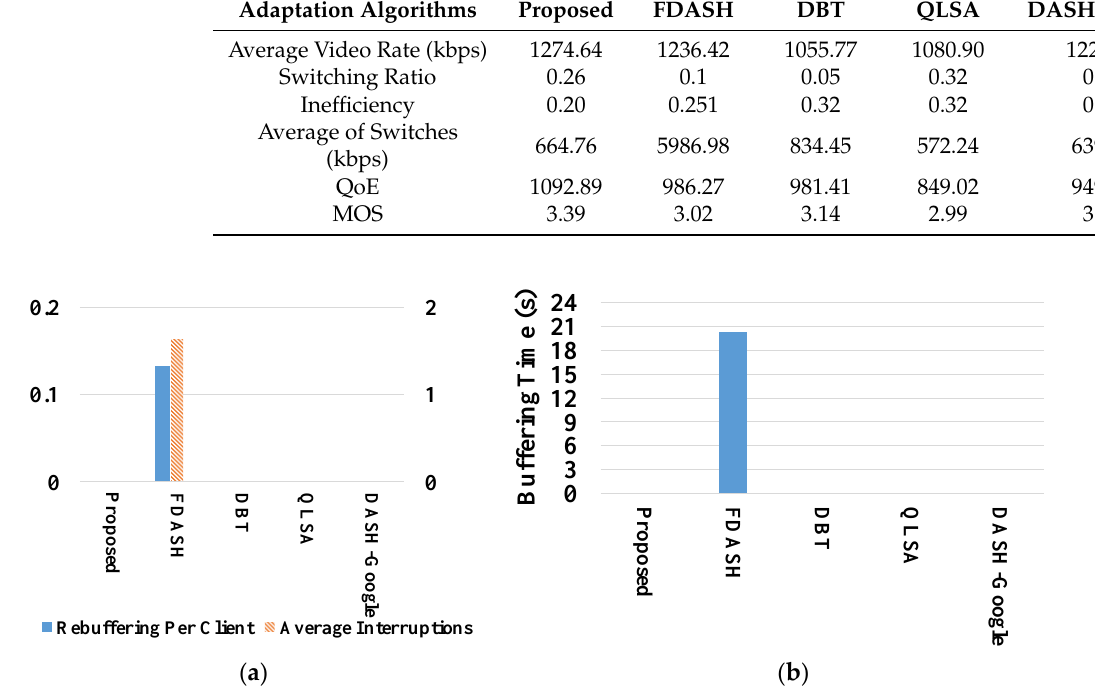
Figure 9. Comparison of ( a ) rebufferings per client, and average number of interruptions, and ( b ) average buffering time when the clients downloaded Dataset 1. The buffer size and segment duration were set to 60 s and 4 s, respectively.